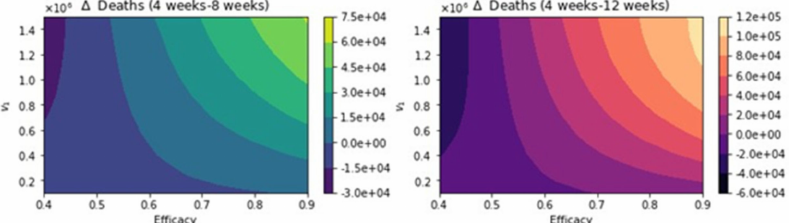
Figure 9. Difference between the total number of deaths for the different vaccination regimens, and under a variety of vaccine efficacies after the first dose and different vaccination rates per day. The basic reproduction number R 0 > 1.